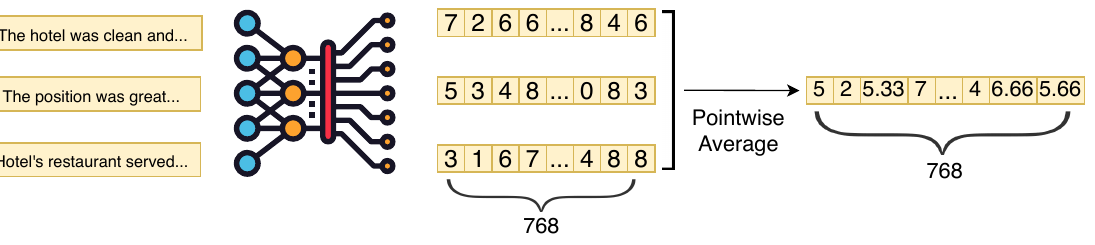
Figure 2. Illustration of the embedding and aggregation